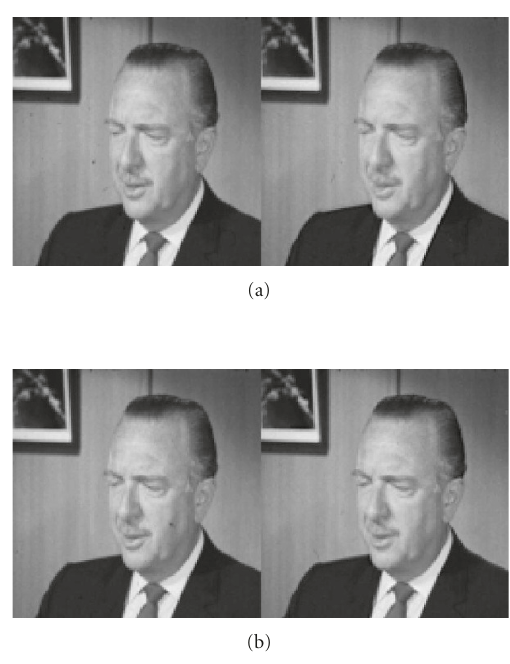
Figure 5: Reconstruction of the Cronkite sequence using 2D adap- tive paraunitary filters (left-original,